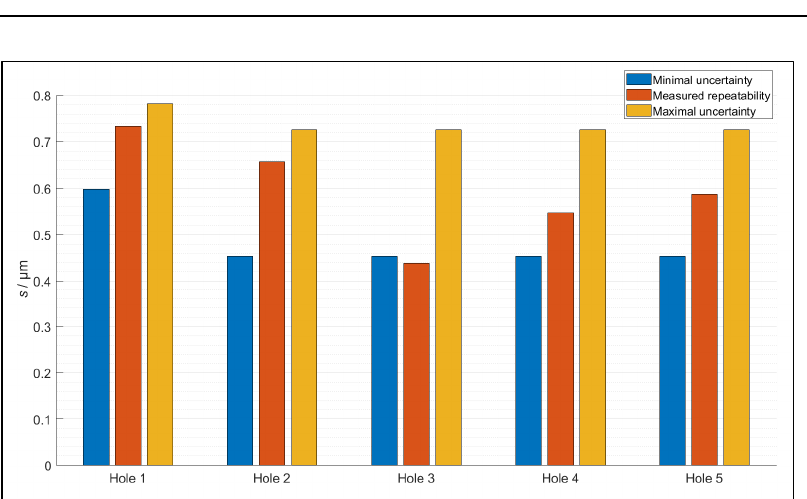
Figure 11. The measured error on the diameter and the virtually determined uncertainty intervals.